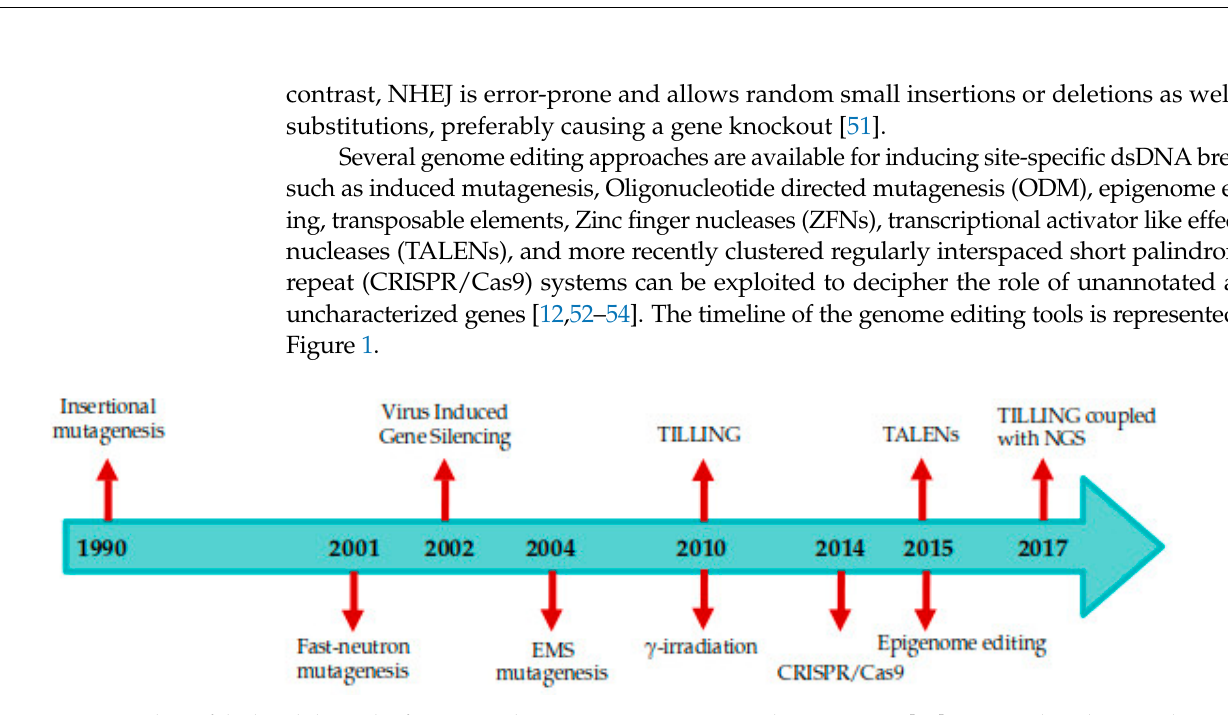
Figure 1. Timeline of the breakthrough of genome editing in tomato. Insertional mutagenesis [55], Virus Induced Gene Silencing (VIGS) [56], Targeted Induced Local Lesions In Genomes (TILLING) [15], TALENs [57], TILLING coupled with NGS [58], Fast-neutron mutagenesis [59], ethyl methane sulphonate (EMS) mutagenesis [9], γ -irradiation [60], CRISPR/Cas9 [61], Epigenome editing [62].